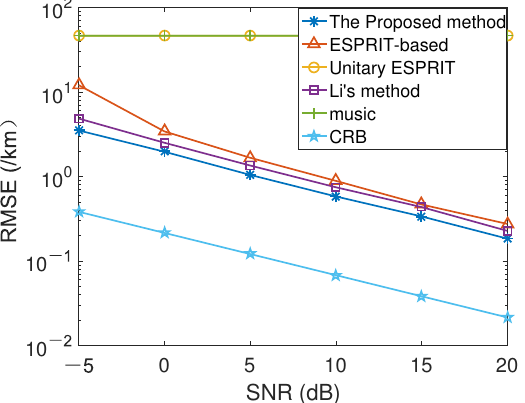
Figure 5. Range estimation RMSE performance versus SNR, L = 50.